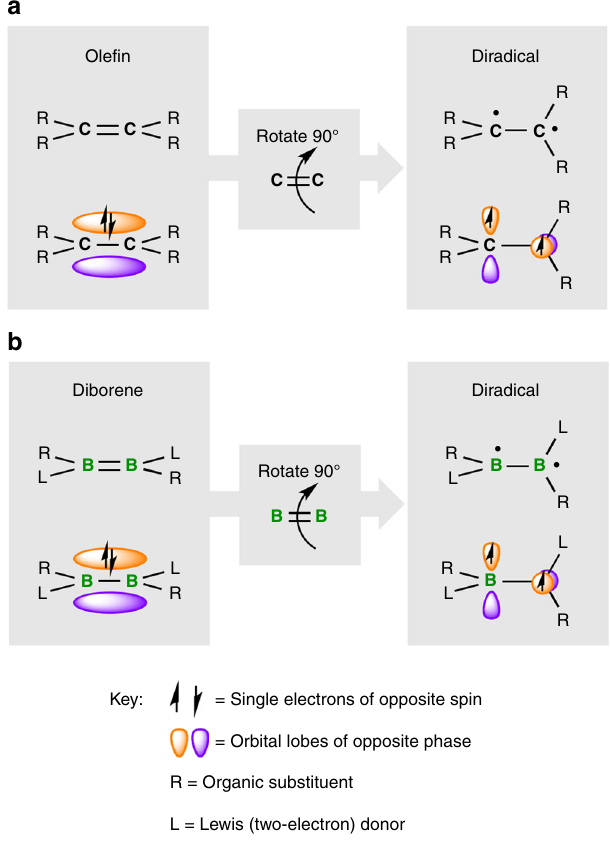
Fig. 1 Twisting double bonds. Orbital changes accompanying the conceptual twisting of element – element double bonds in alkenes ( a ) and diborenes ( b ) to form diradical